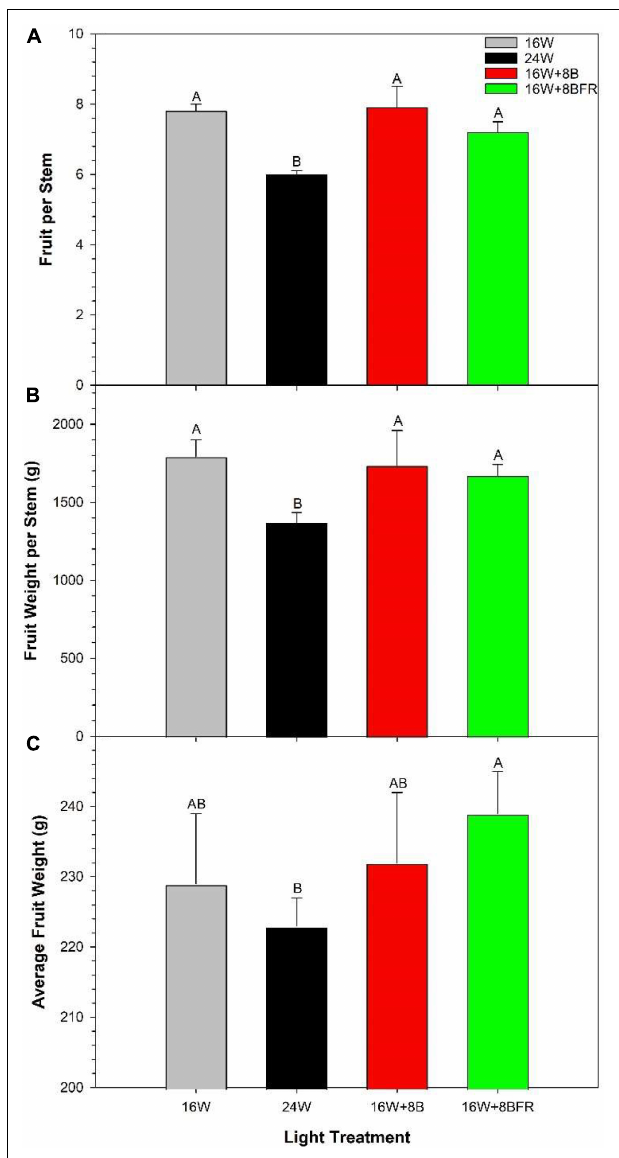
FIGURE 7 | Total yield parameters from peppers grown under all light treatments from October 5th, 2020 to March 24th, 2021. (A) Represents the accumulated number of fruit harvested per stem, (B) represents the accumulated number of fruit harvested per stem, and (C) represents the average weight per fruit (fruit size). Within each panel, letter groups (A, B) represent a statistical difference as determined by a one-way ANOVA with a Tukey-Kramer adjustment ( p <